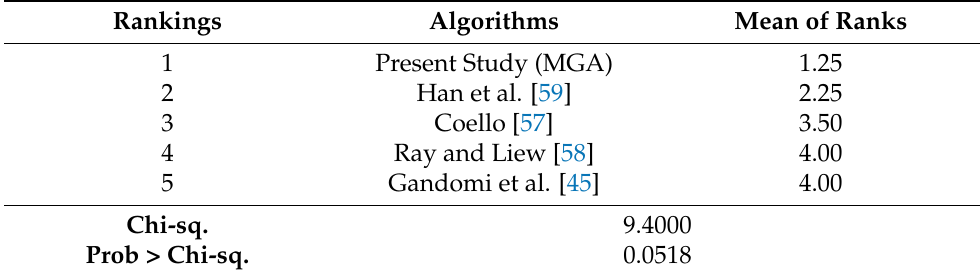
Table A4. Friedman statistical test results for the tension or compression spring design